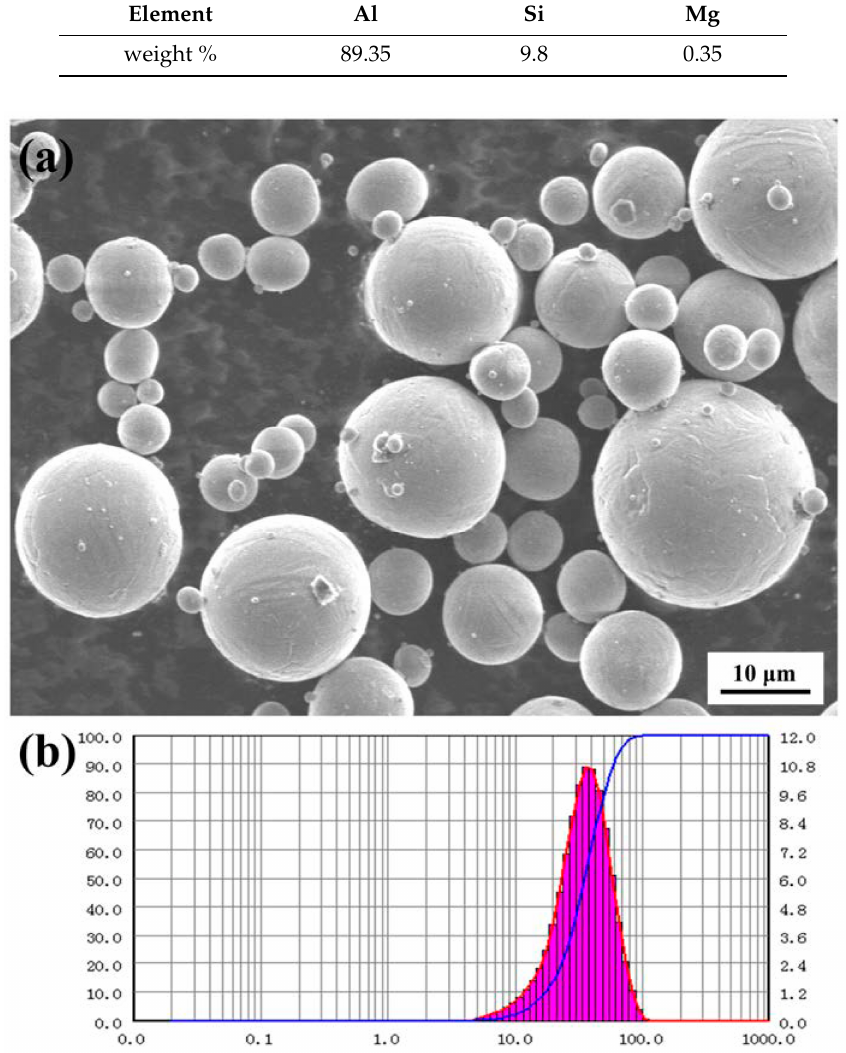
Figure 1. Spherical alloy powder and particle size distribution used in the experiments: ( a ) SEM image of AlSi10Mg powder; ( b ) particle size distribution of AlSi10Mg powder.